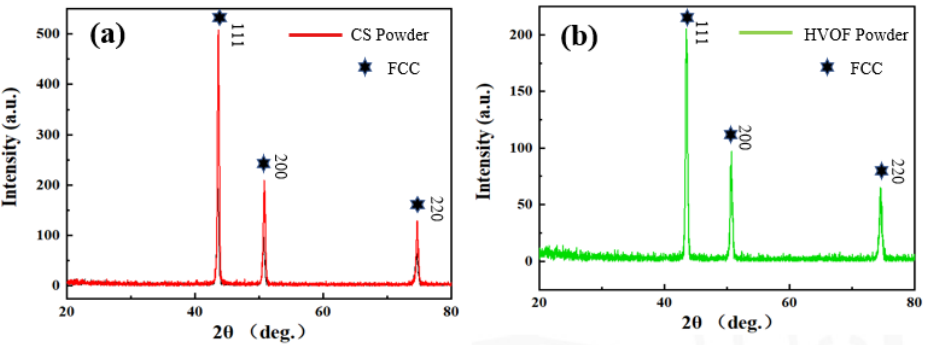
Figure 2. XRD patterns of CoCrFeNiMn high-entropy alloy powders. ( a ) CS powders; ( b ) HVOF